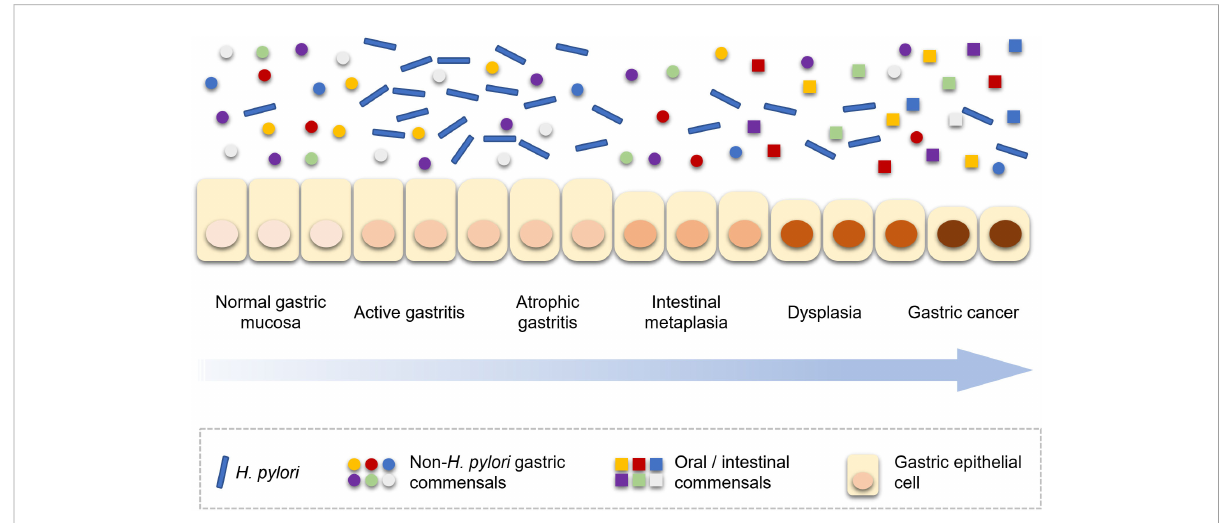
FIGURE 1 H. pylori and non- H. pylori microbes in the development of gastric carcinogenesis. H. pylori , Helicobacter pylori .